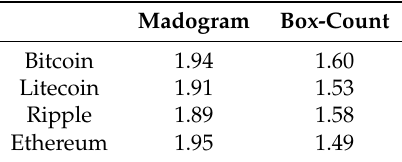
Table 3. Fractal dimension